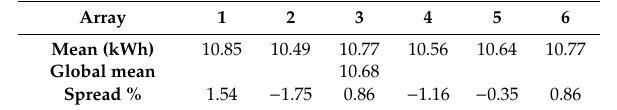
Figure 6. ( a ) Energy produced by array #4 in six months and its mean value as red line; ( b ) upper and lower BB 20 of array #4 in red color, and EMA 20 in magenta color. ( c ) and ( d ) refer to array #5. ( e ) and ( f ) refer to array #6. Table 2. Mean energy and spread with respect to the global mean for the semester analysis. Array